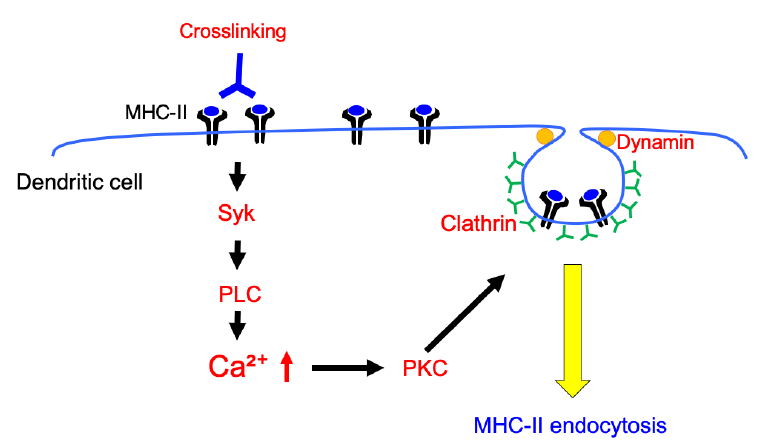
Figure 9. Schematic overview of MHC-II crosslinking induced signaling, which induces MHC-II endocytosis in BMDCs. MHC-II crosslinking induces Syk and PLC-mediated cytosolic Ca 2+ mobilization. Activation of PKC, which is one of the molecules activated by cytosolic Ca 2+ mobilization, induces endocytosis of MHC-II. These signal transductions induce colocalization of MHC-II with clathrin, which results in an induction of clathrin-dependent and dynamin-dependent MHC-II endocytosis.